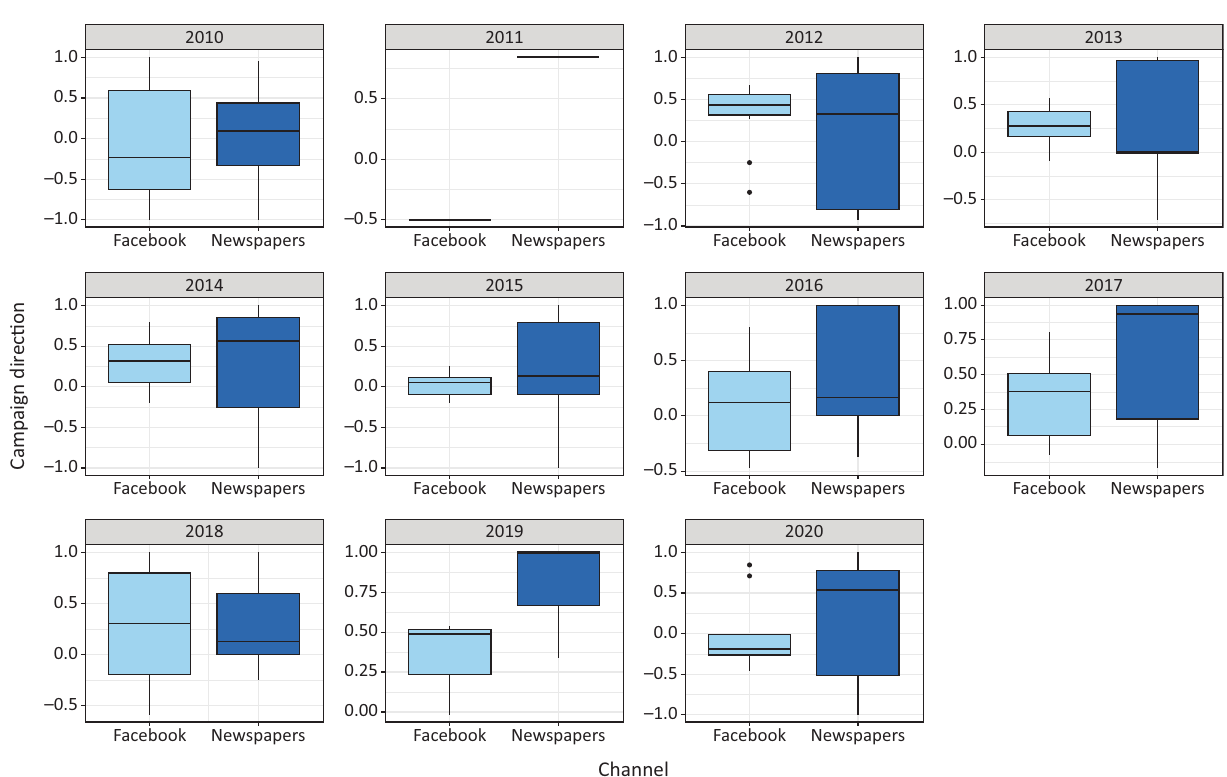
Figure 5. Development of the difference between the government camp and the challenger camp ( = campaign direction) in terms of Facebook posts and newspaper advertisements from 2010 to